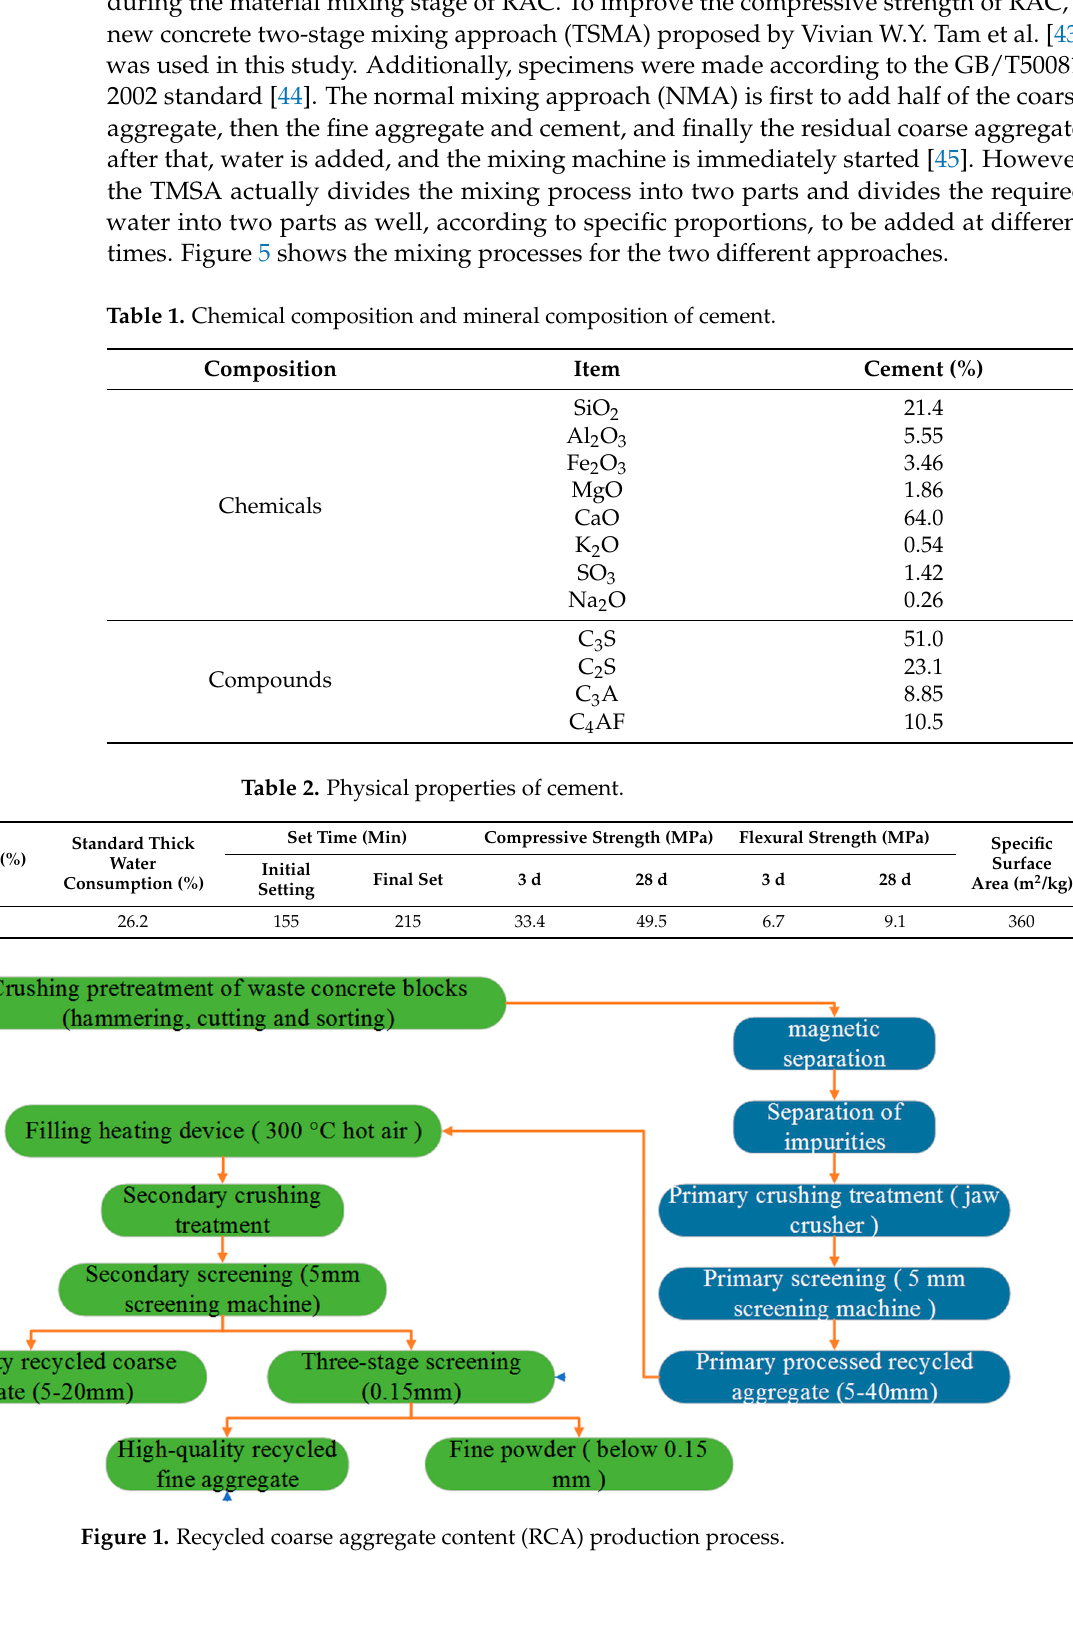
Figure 2. Natural coarse aggregate ( NCA), RCA and river sand. Table 3. Physical properties of the main materials. Property